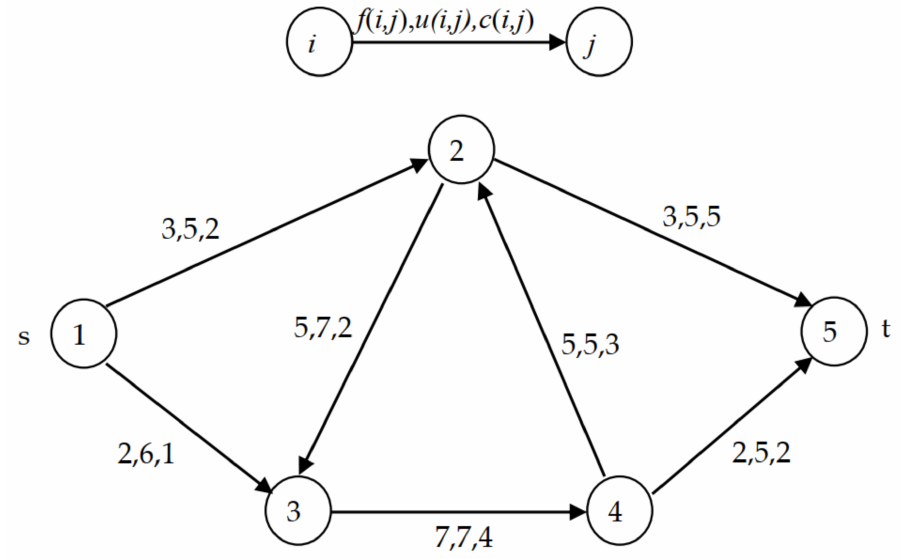
Figure 1. A network G and a flow f